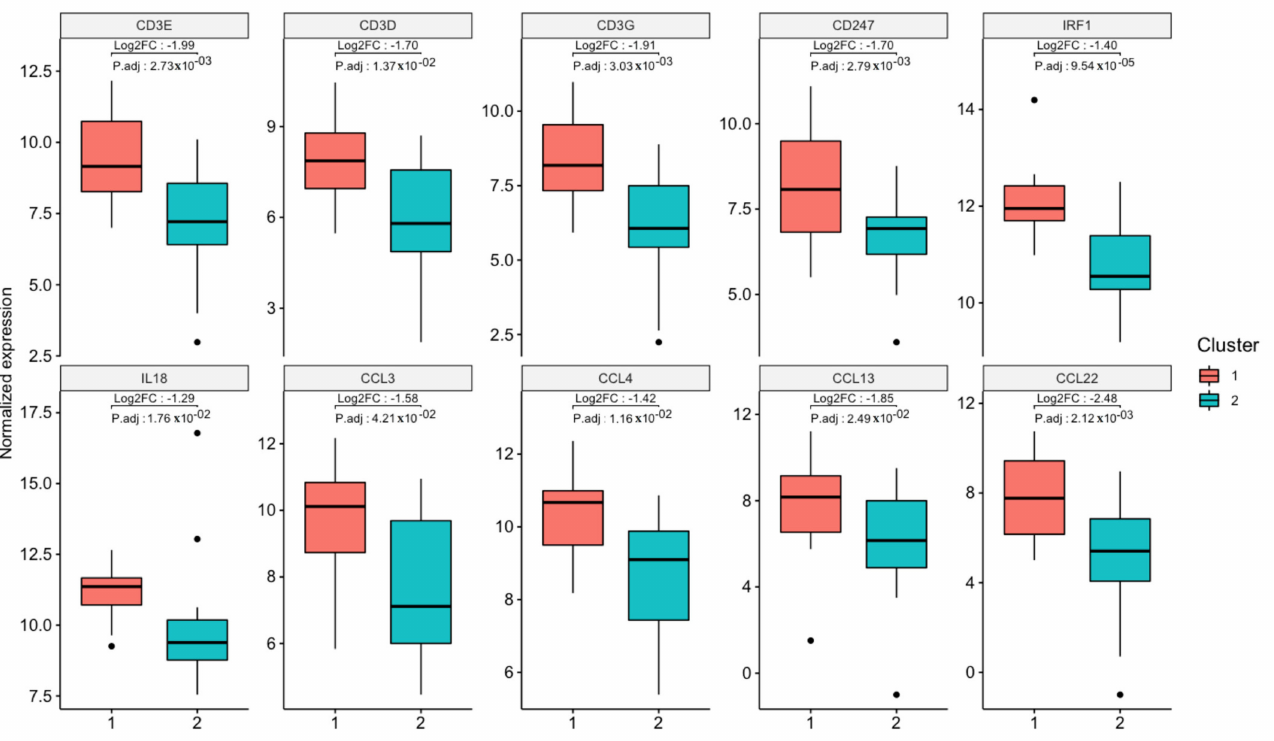
Figure A2. Expression of genes linked to infiltration of the immune cells according to the cluster- ing groups. The following genes are overexpressed in group 1, reflecting significant immune cell infiltration in this group: CD3E, CD3D, CD3G, CD247, IRF1, IL18, CCL3, CCL4, CCL13 and